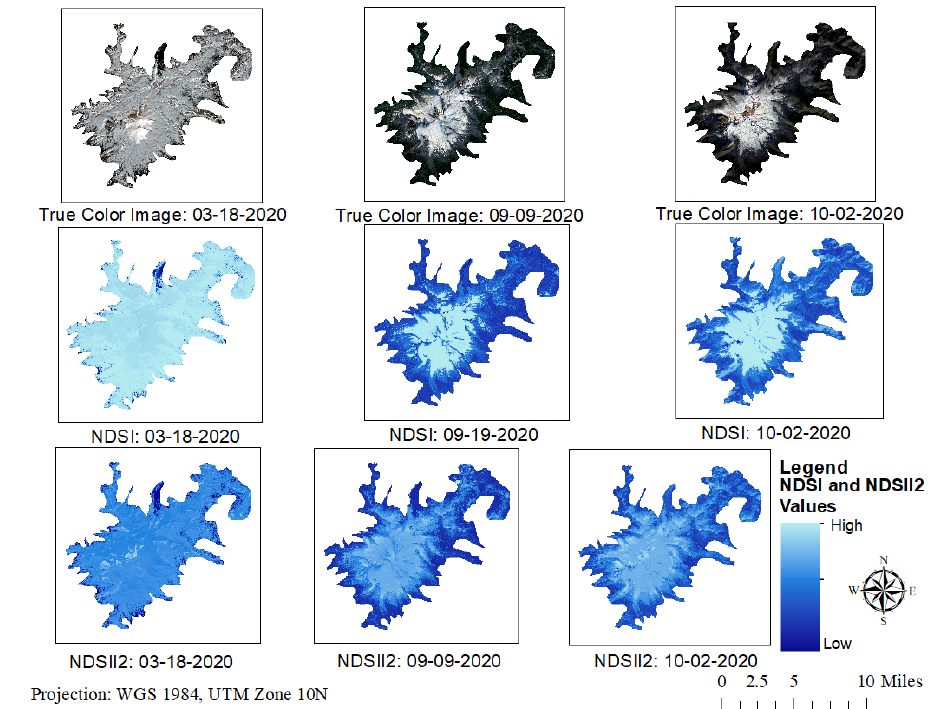
Figure 3 : True color images (top), NDSI (middle), and NDSII2 (bottom) maps produced (WGS 1984